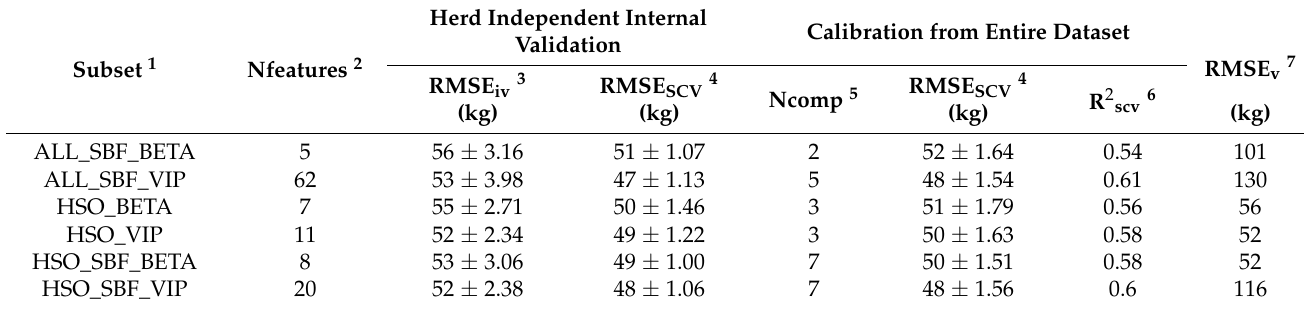
1 Subsets of predictors after the recursive feature elimination (RFE) selection step; SBF means that a first selection was made before RFE using selection by filter; VIP (variables in projection) and BETA (beta coefficients) refers to the ranking methods chosen for RFE; ALL means that originally all the mid-infrared spectral points were considered; HSO means that only the mid-infrared spectral points at wavenumbers (950 cm − 1 , 1600 cm − 1 ), (1750 cm − 1 , 1800 cm − 1 ), and (2600 cm − 1 , 3000 cm − 1 ) were initially considered before selection steps. 2 Corresponding number of features to the subset. 3 Root mean squared error from the herd-independent validation repeated 101 times. 4 Root mean squared error of 10-folds stratified cross-validation. 5 Number of latent variables kept by the partial least square regression. 6 Coefficient of determination. 7 Root mean squared error of validation using Australian